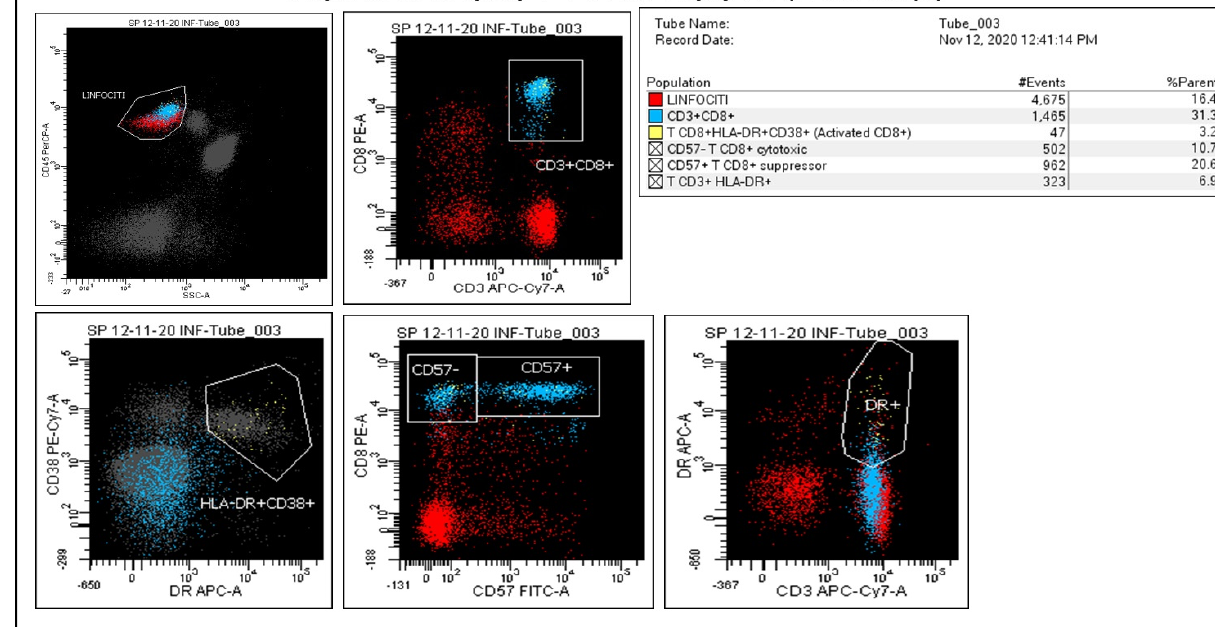
Figure 11. Gating Strategy for Monocytes CD33, CD45, CD16, CD56, and CD14 quantification. A doublet exclusion gate based upon (FSC-A vs. FSC-H) was utilized to gate on singlet cells, and within this singlet cell gate a lymphocyte gate was drawn in a dot plot of FSC-A vs. SSC-A. Comparative Dot plots of CD3 and CD57 on the X-axis vs. CD33, CD45, CD16, CD56, and CD14. The instruments were set using one set of target values as described in the Method section. Percentages of positive cells were determined after gating on CD45 positive cells following the doublet exclusion.